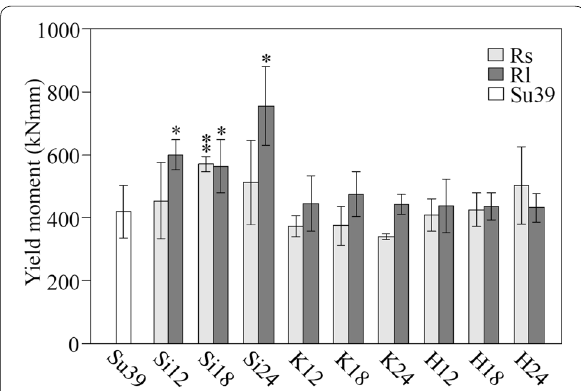
Fig. 8 Averages of reinforcement effect on yield moment. See Fig.